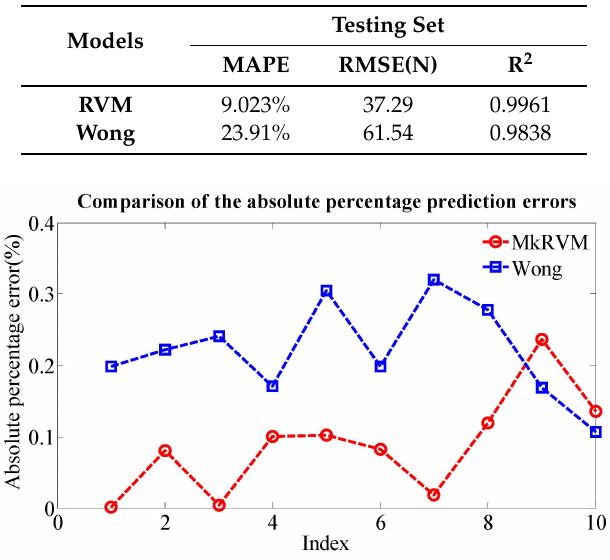
Table 6. Comparison of the prediction performance of the RVM model and the traditional model.